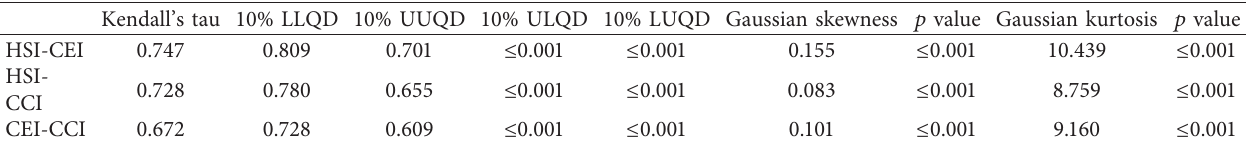
Table 6: Sample bivariate dependence measures of uniform